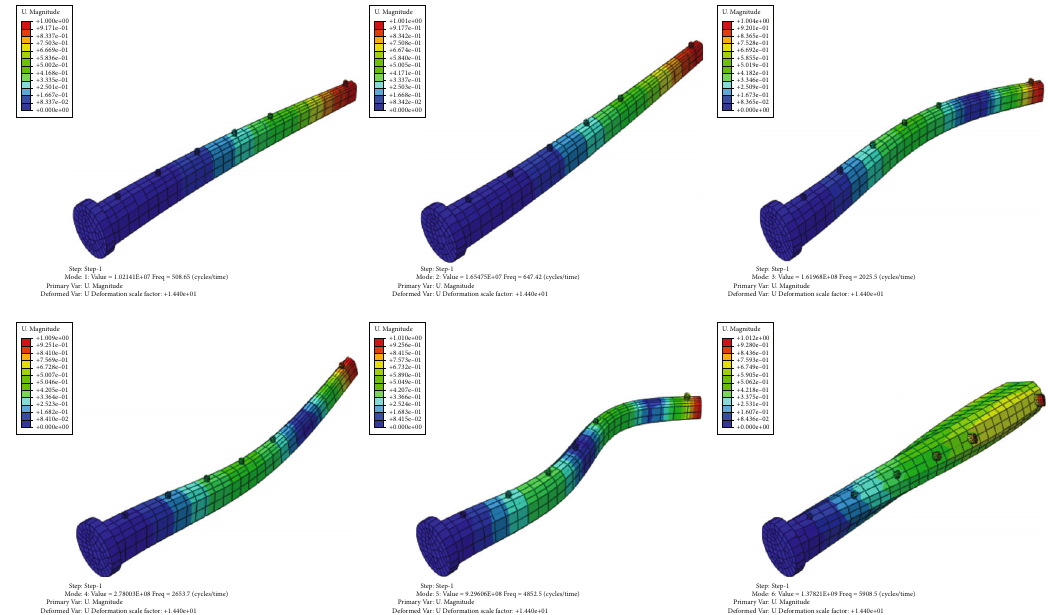
Figure 11: The 1st to 6th order mode shape diagrams of test probe.